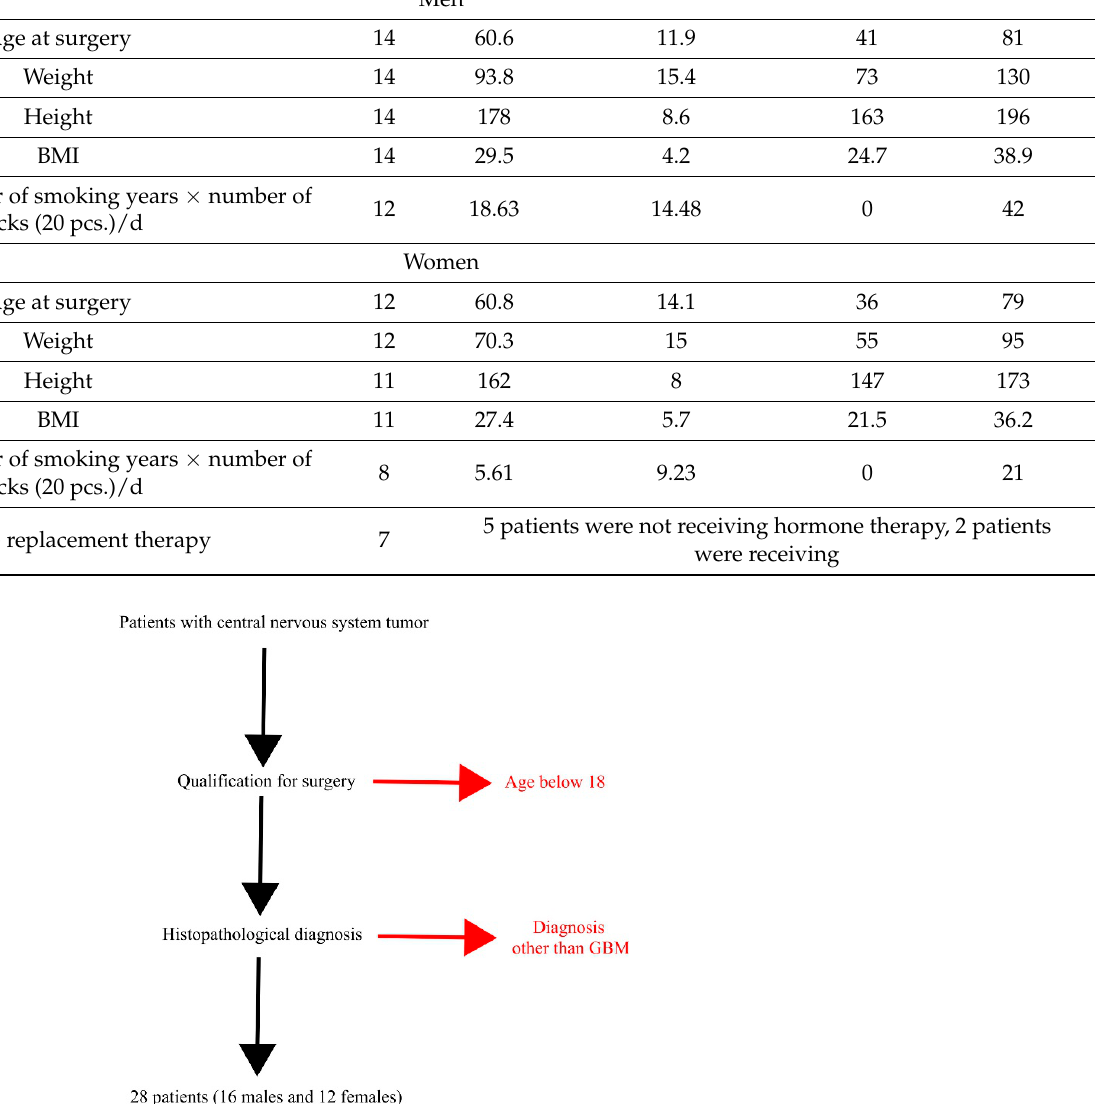
Table 1. The statistical characteristics of the patients.